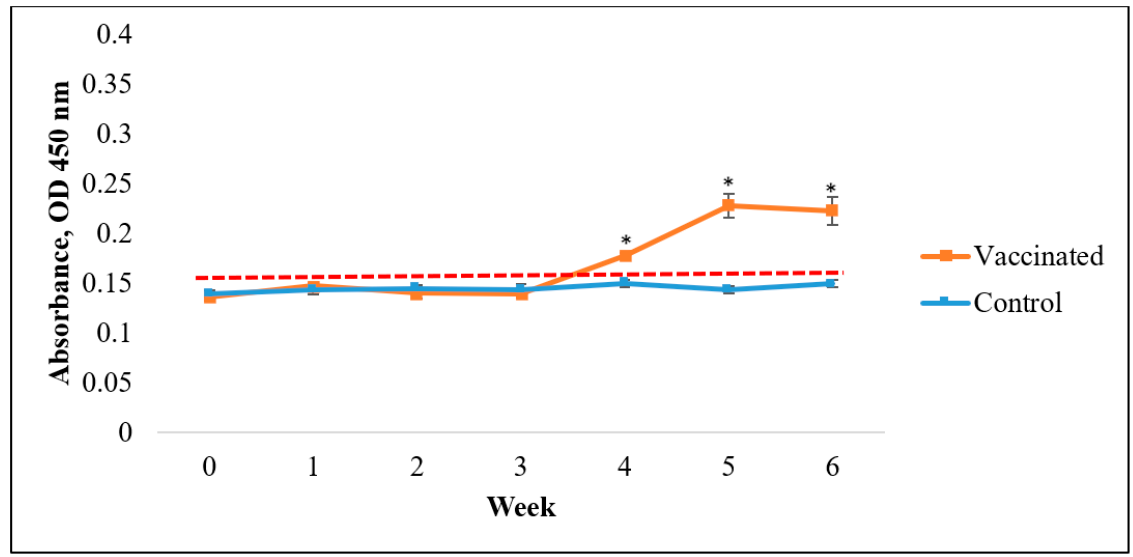
Figure 5. Specific antibody (IgM) levels against V. harveyi in vaccinated Asian seabass (mean ± SE, n = 6) 6 weeks post-vaccination. Asterisks indicate a significant difference ( p < 0.05) from the control.